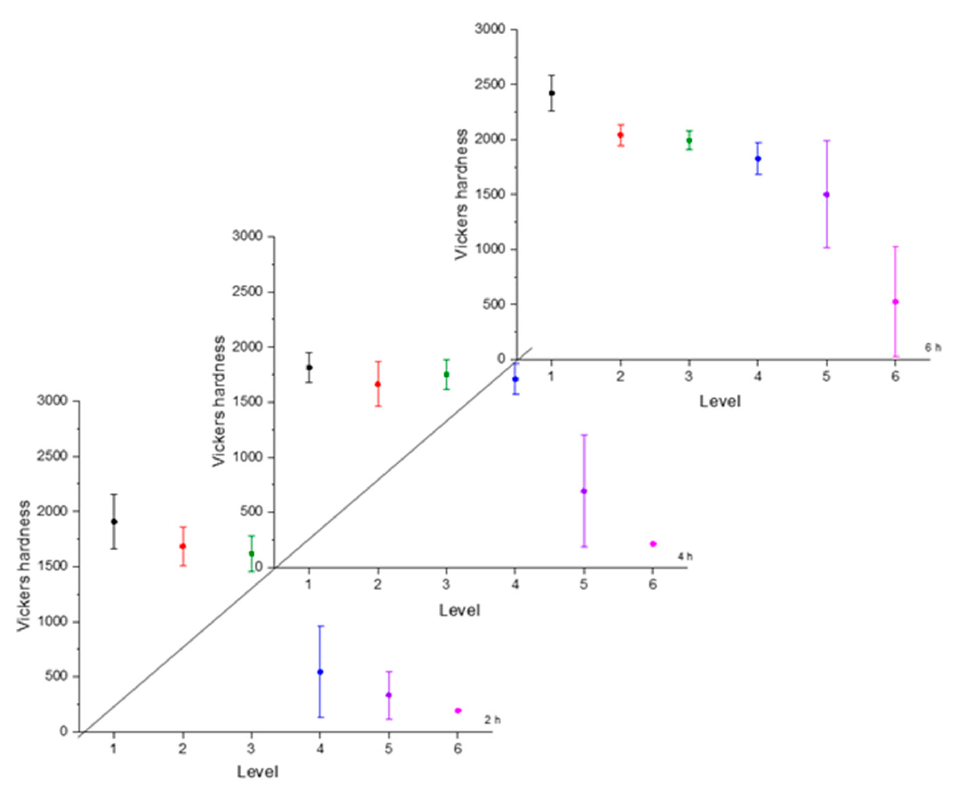
Figure 7. Microhardness evolution after boriding treatment at 1000 °C.